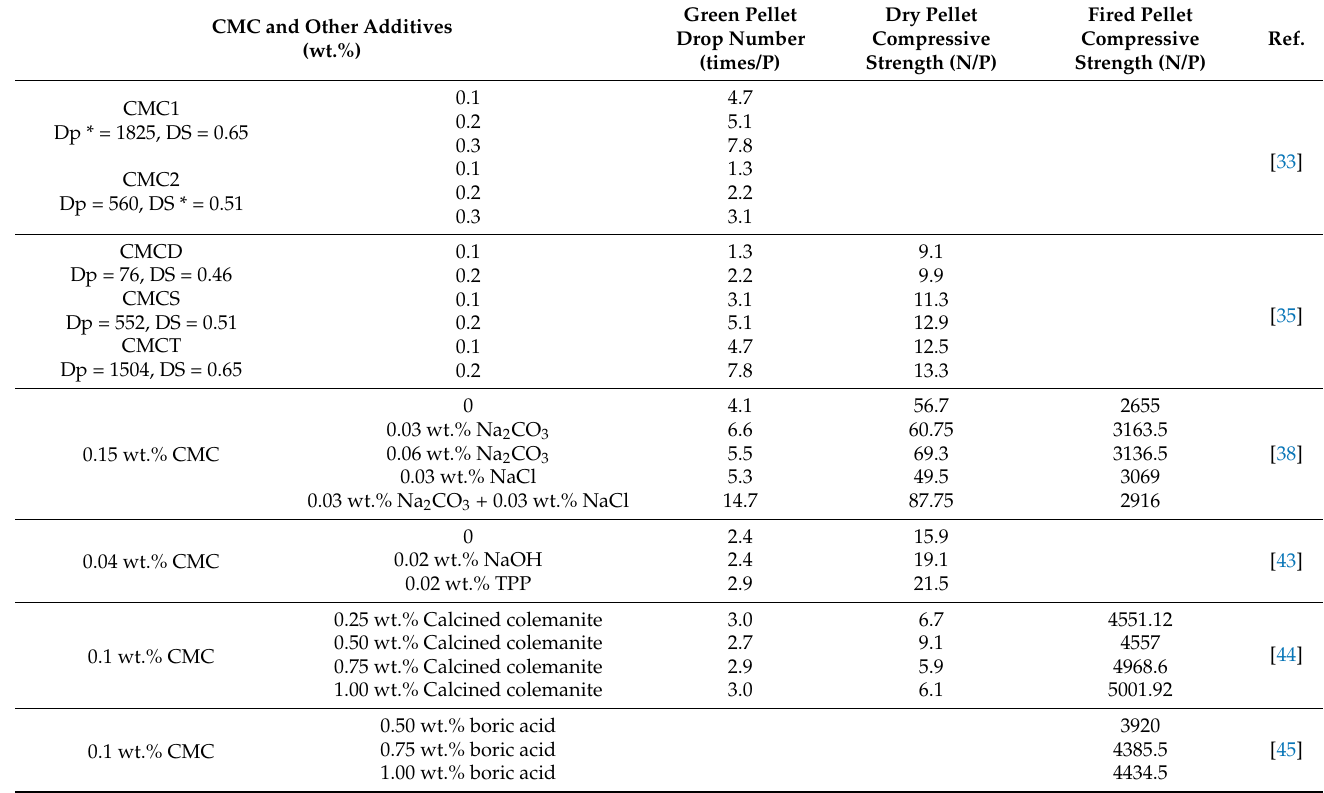
Table 1. The effect of CMC with other additives on the performance of pellets. CMC and Other Additives